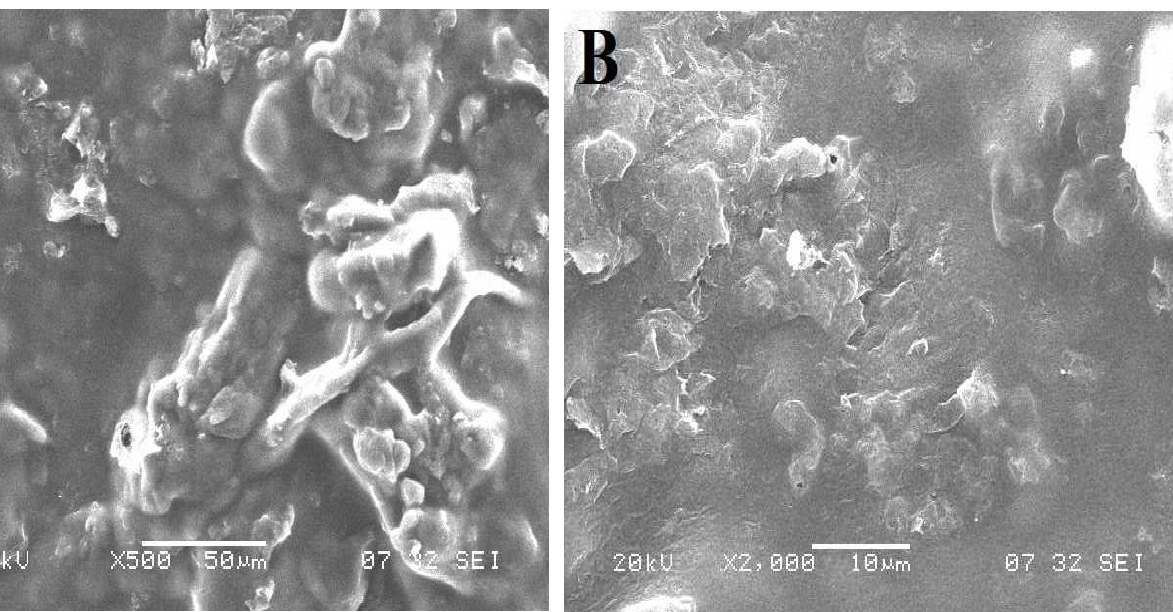
Figure 1. Overlain FT-IR spectra of pure drug neratinib and neratinib–PEG solid dispersion.